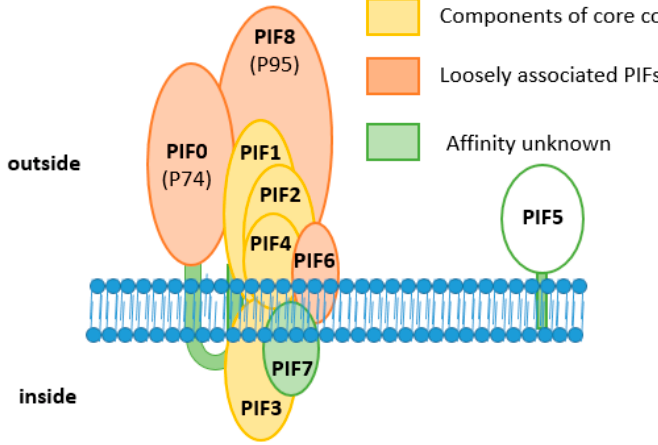
Figure 5. Model of the ODV entry complex. In yellow, the components of the core complex (PIF1, 2, 3 and 4); and in red, the PIFs that associate to the entry complex with lower affinity (PIF0, 6 and 8). PIF7 is depicted in green as this protein was detected in the entry complex under non-denaturing conditions but the affinity of this PIF for the complex is not known. PIF5 does not make part of the entry complex and is depicted in white.